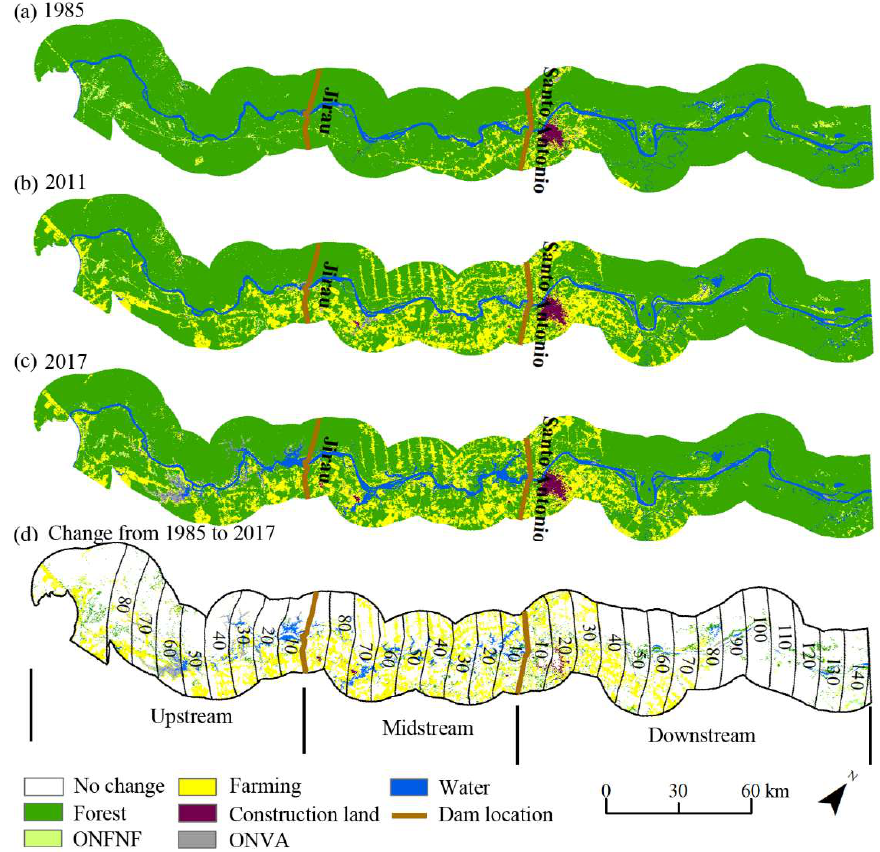
Figure 2. Maps of land cover categories in ( a ) 1985; ( b ) 2011; ( c ) 2017; ( d ) Change direction from 1985 to 2017 and buffer zones for two dams in the study area (Note: ONFNF: other non-forest natural formation, ONVA: other non-vegetated areas. The numbers in ( d ) indicate the distance from buffer zones to the dam. The number in upstream shows the distance to the Jirau dam. The number in midstream and downstream is the distance to Santo Antônio dam).